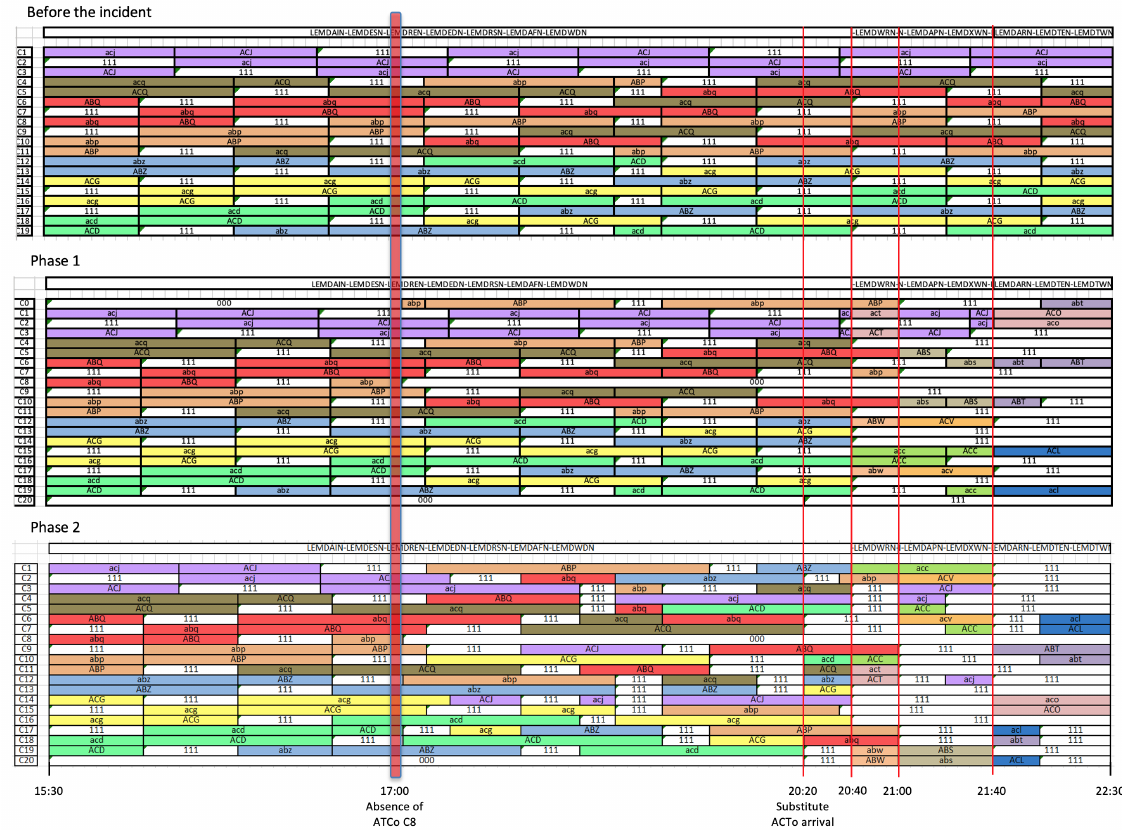
Figure 15. Solution before the incident, solution derived in Phase 1 and solution for Instance